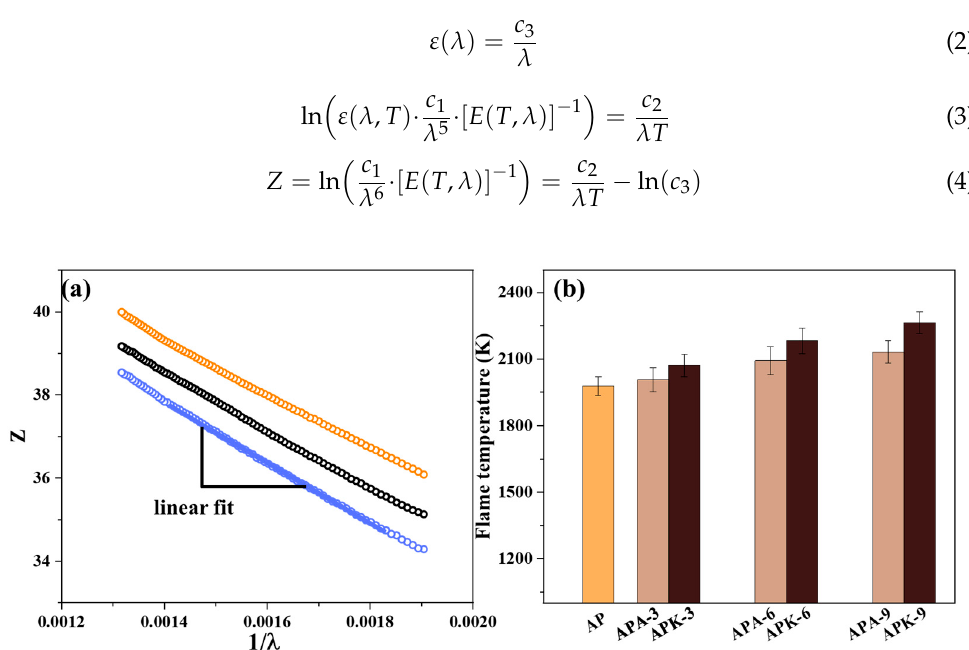
Figure 6. ( a ) The linear fitting curve of the combustion emission spectrum and ( b ) the average combustion temperature of each sample.